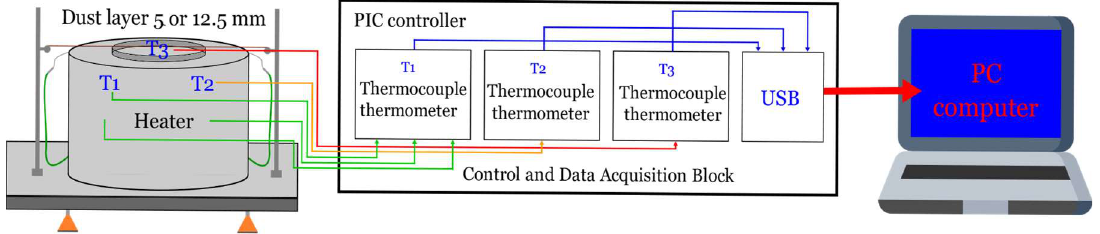
Figure 2. Measurement device for minimum ignition energy of Holi dust cloud. Figure 3. Measurement device for minimum ignition temperature of Holi dust layer.